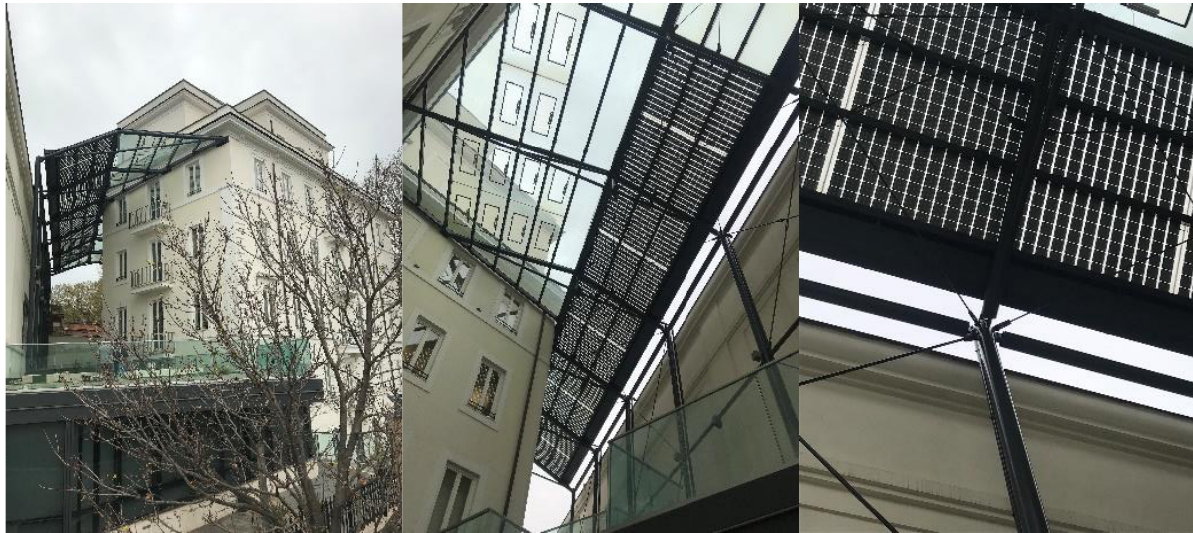
Figure 7. Positive example of the “ reversibility ” criteria on the solar intervention of Palazzo Leonori in Rome (Italy), where the transparent BIPV roof is detached from the original XIX Century Palace by metallic columns [75] (Source: Elena Lucchi).